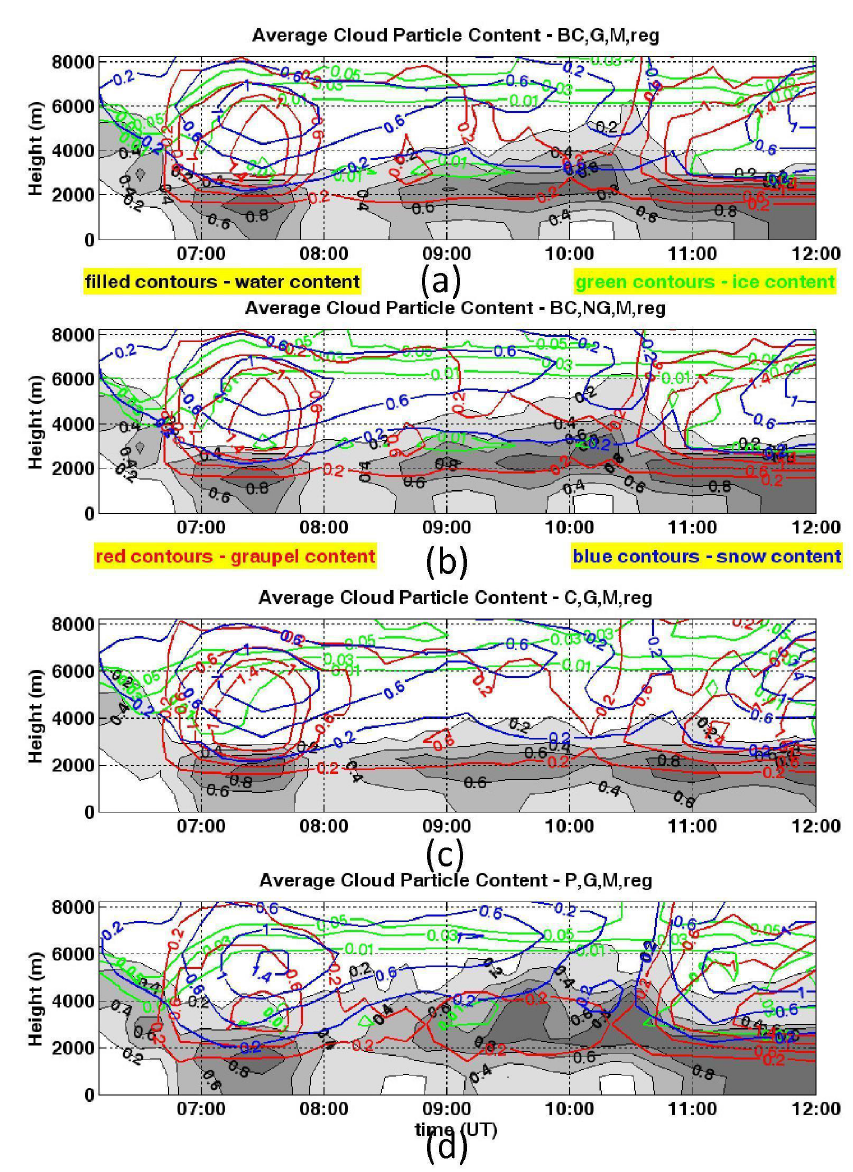
Fig. 7. Average cloud particles’ mixing ratios as function of time and height in the area which is marked by a red rectangle in Fig.